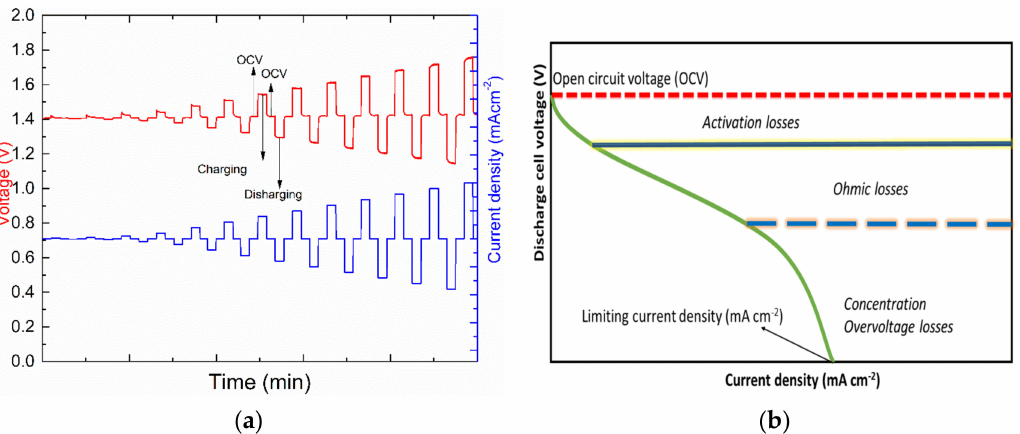
Figure 5. ( a ) Current and voltage profile at consecutive charging, OCV and discharging for polarization curve ( b ) Polariza- tion curve with indication of different zone of losses in